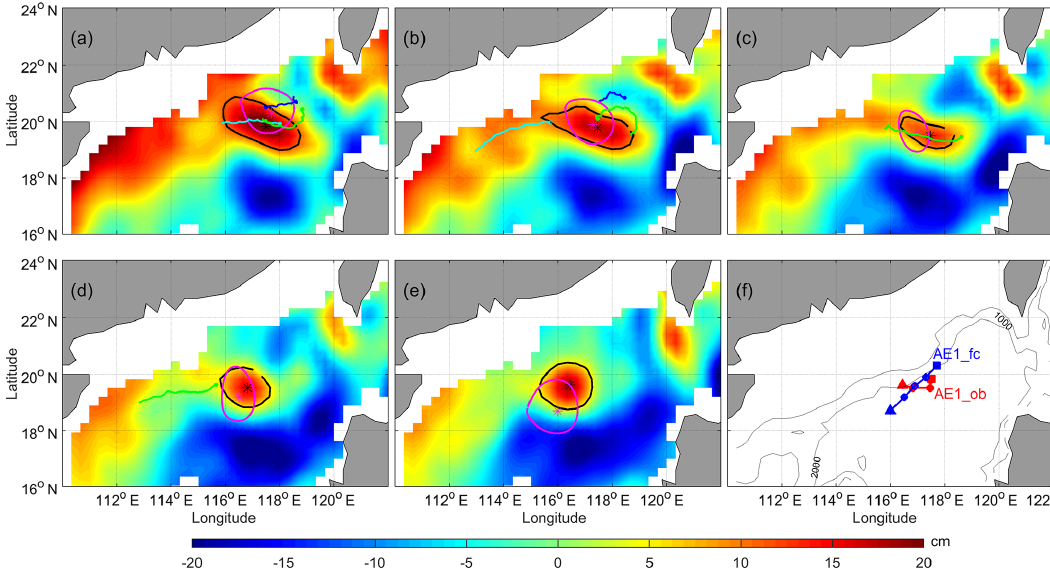
Figure 9. Same as Fig. 8, but for Exp2; the experiment period is the 10 December 2003 to the 9 January 2004.